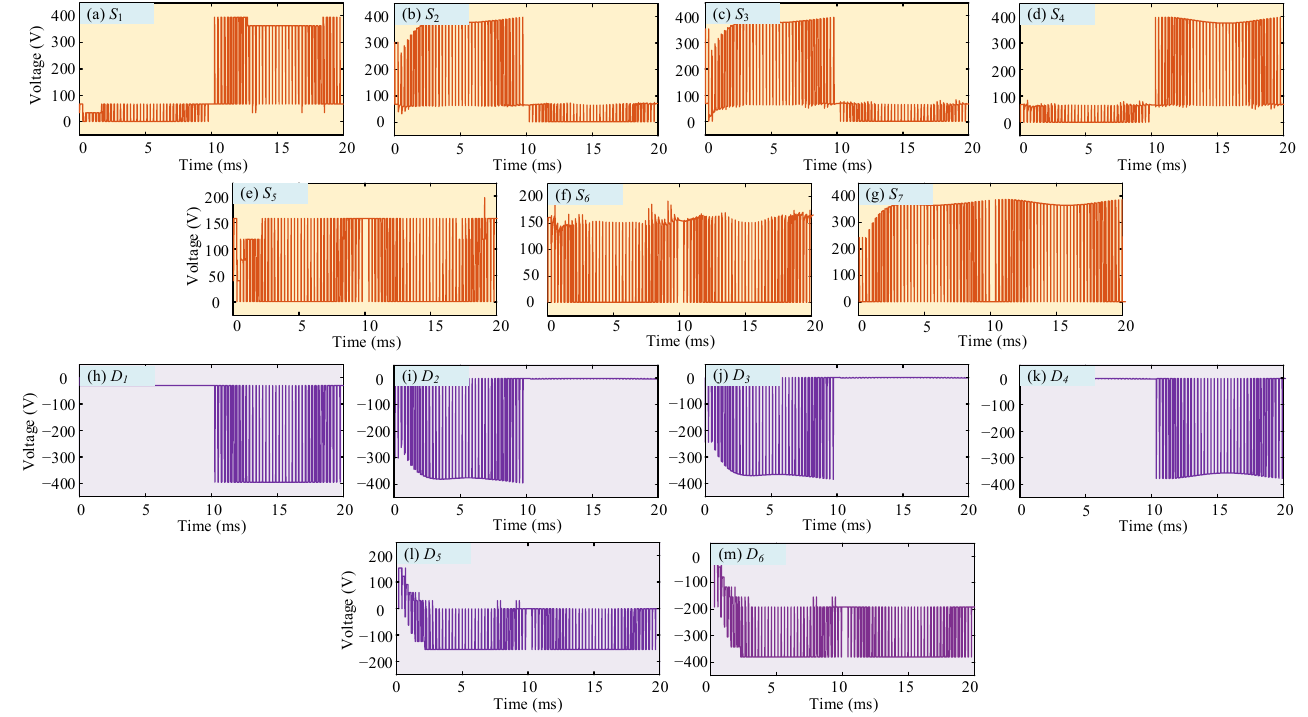
Figure 12. Grid voltage and current waveforms with step change of DC input voltage in grid-connected mode: ( a ) input DC voltage variation, ( b ) grid voltage V g , ( c ) grid current i g .